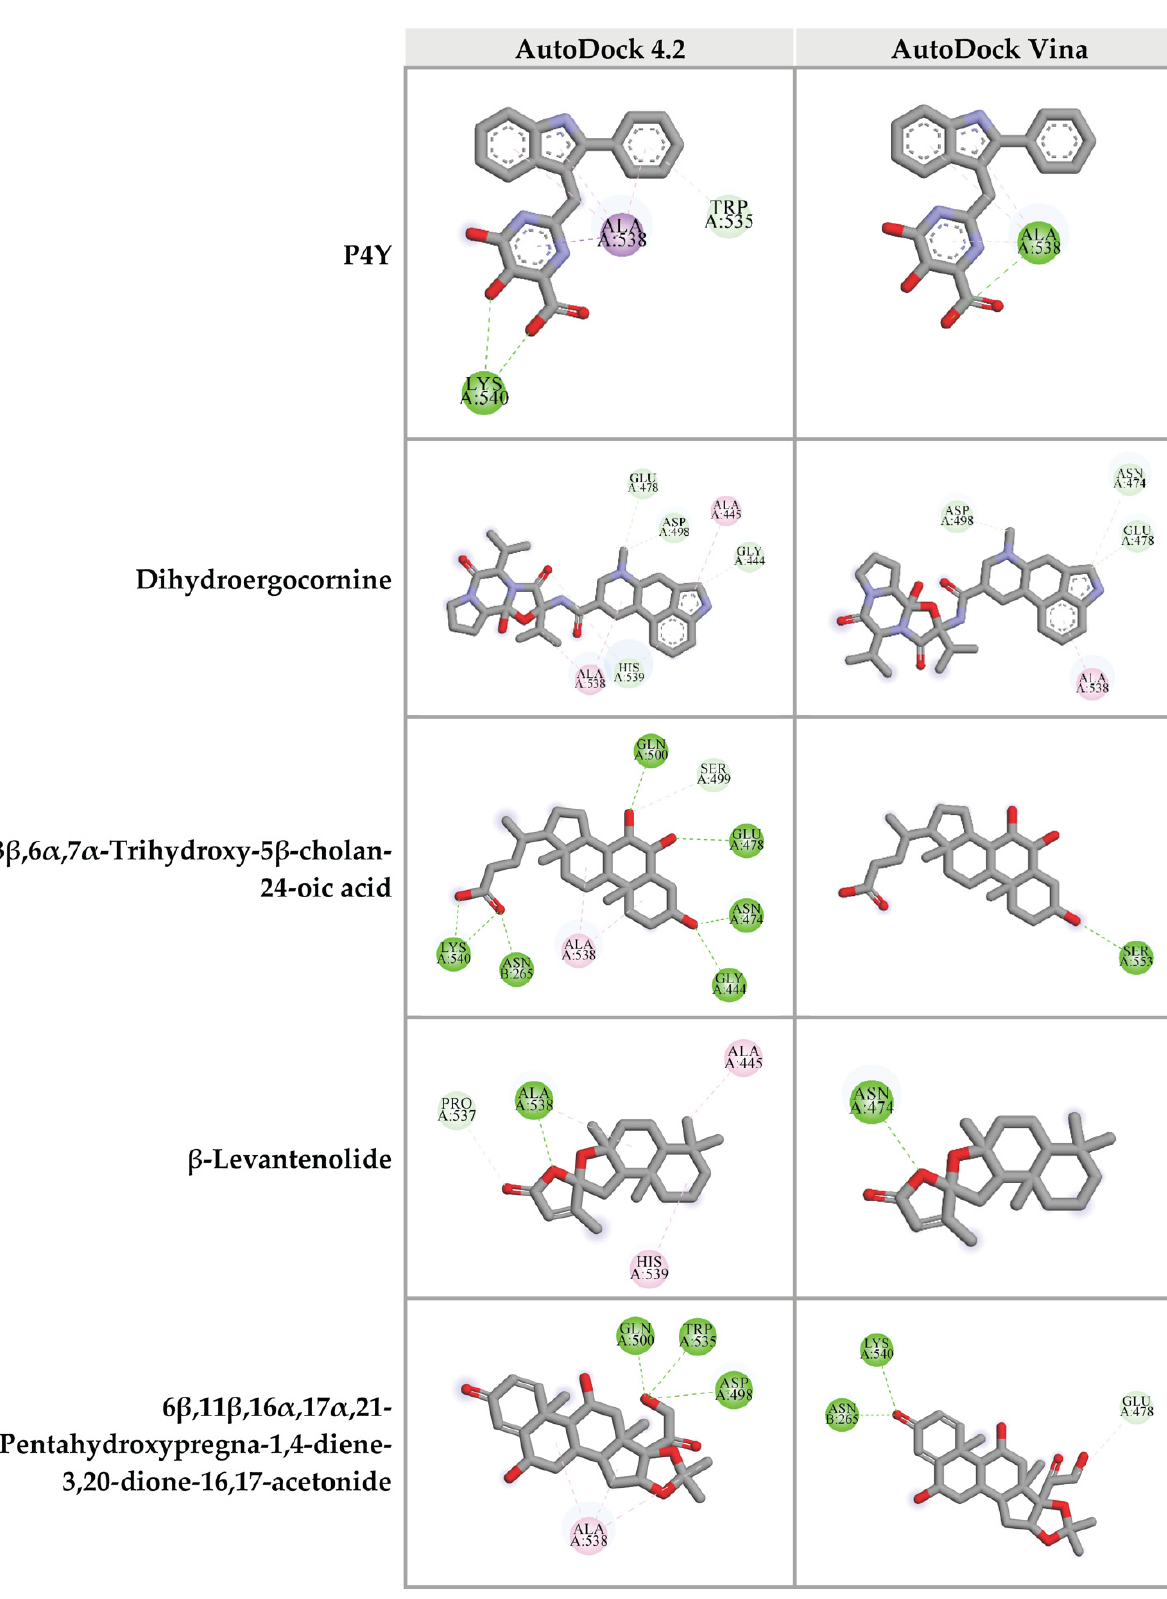
Figure 7. Three-dimensional schematic interaction between HIV-1 RT (PDB: 3QIP) at the RNase H active site and candidate ligands. Balls and sticks represent amino acid residues and ligands, respectively. Green dashed lines indicate hydrogen bonds. Pink and purple dashed lines indicate hydrophobic bonds.